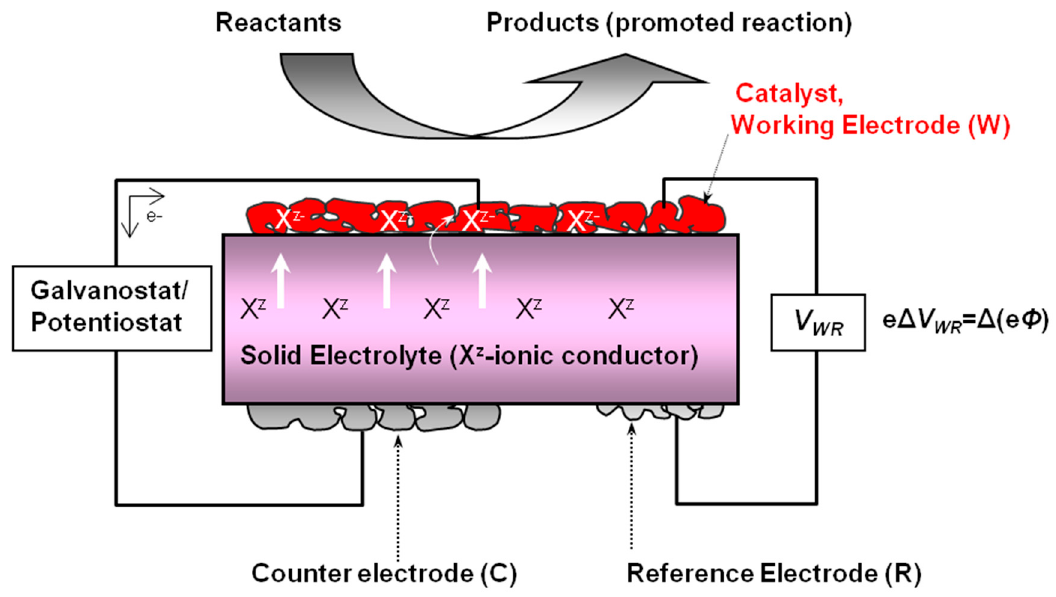
Figure 1. Schematic representation of a solid state electrochemical cell, through which the EPOC concept can be applied. X: type of ion transferred from the solid electrolyte to the catalyst surface and z: ion charge (e.g., O 2 − , Na + , K + , H + ).